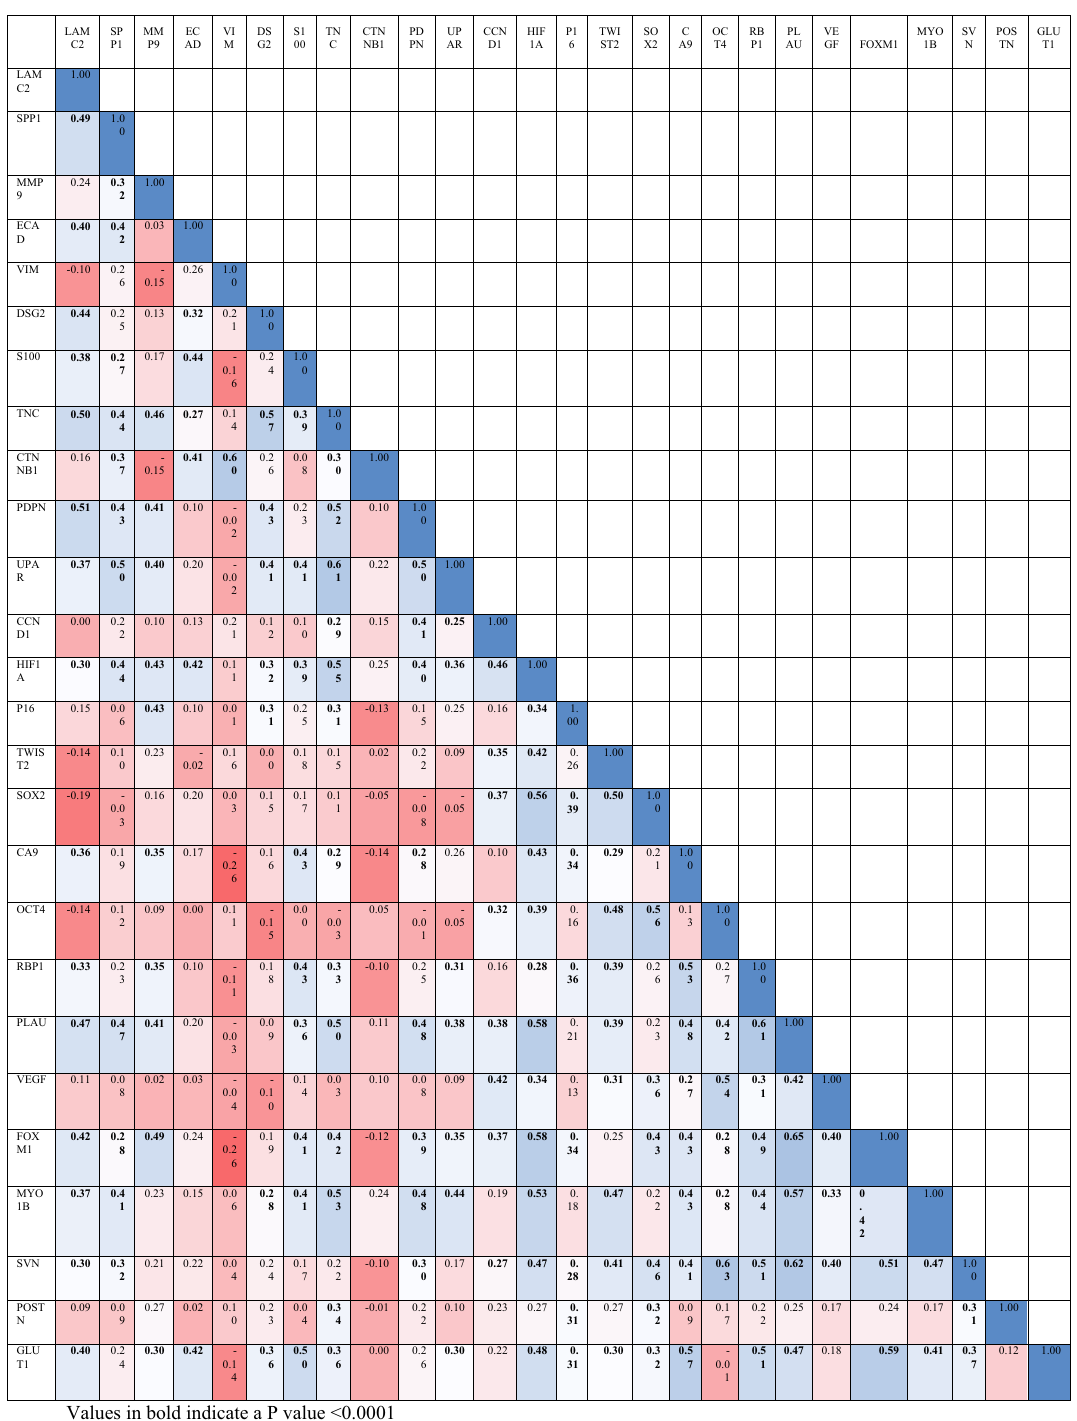
sion of LAMC2 ( P value = 0.02), VIM ( P value = 0.001), TWIST2 ( P value = 0.03) and SOX2 ( P value = 0.02) were the significantly associated with the cervical lymph node involvement. Molecular markers useful in differentiating the clinical stages in OTSCC. The relative expression of LAMC2 ( P value = 0.02), VIM ( P value = 0.02), HIF1A ( P value = 0.01), TWIST2 ( P value = 0.03) and SOX2 ( P value = 0.02) were found to be significantly differentially expressed among the early and advanced stage tumors.